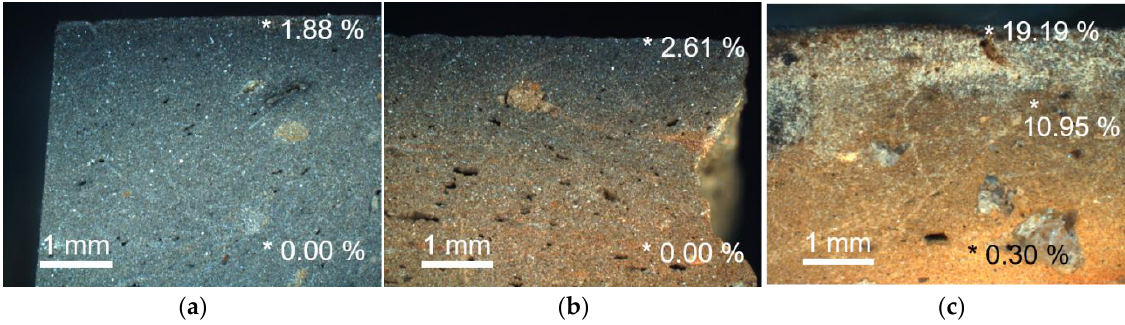
Figure 2. Cross-sectional images of pottery samples: ( a ) PN1, ( b ) PN2, and ( c ) PN3. *: Carbon content figures from previous studies [36,41].